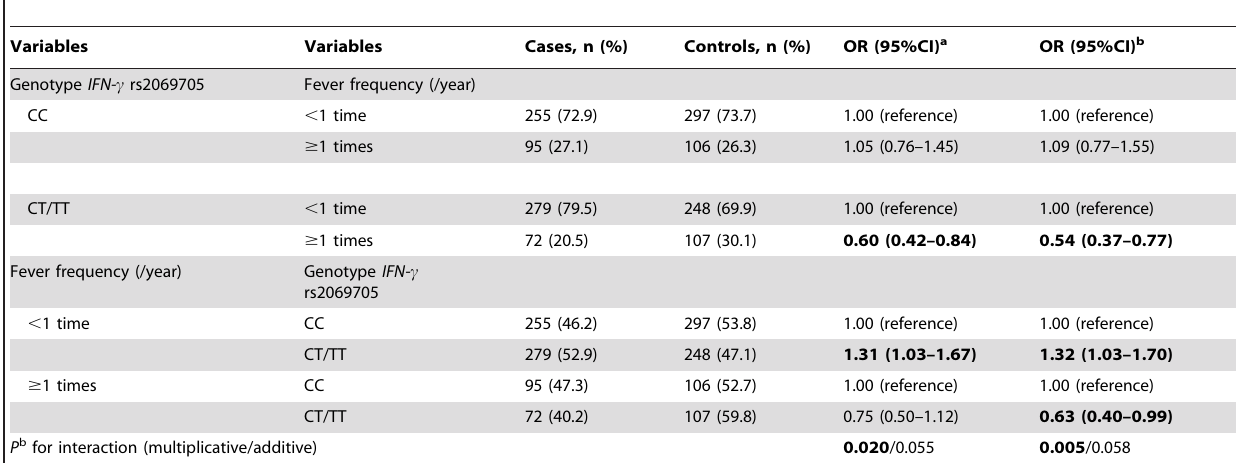
Table 4. Multivariate odds ratio of breast cancer associated with previous fever frequency by genotype of IFN- c rs2069705.